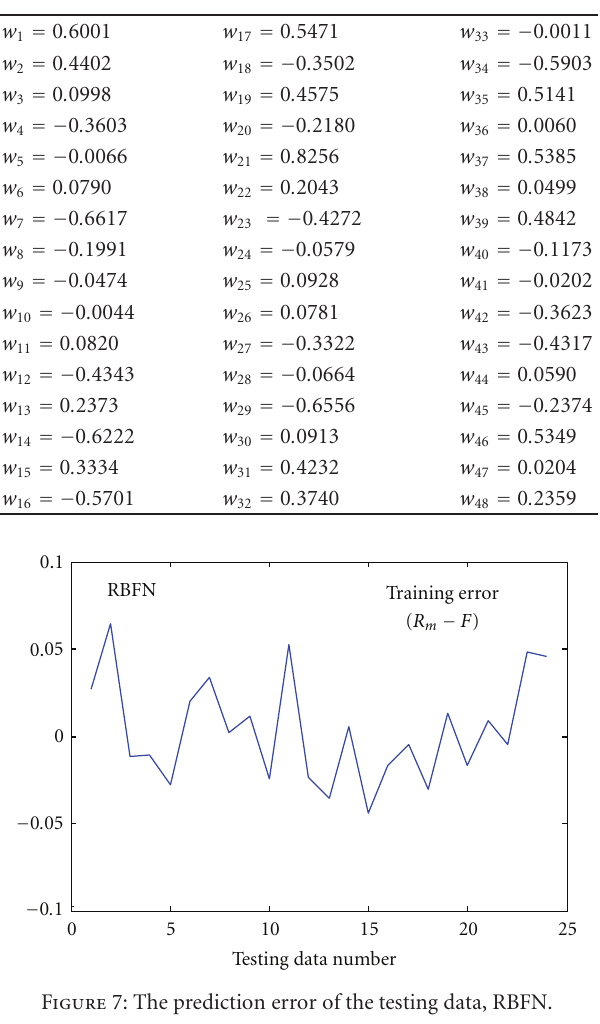
results with BP algorithm have taken place when FO Sugeno fuzzy model has been used; RMSE = 0.0449.